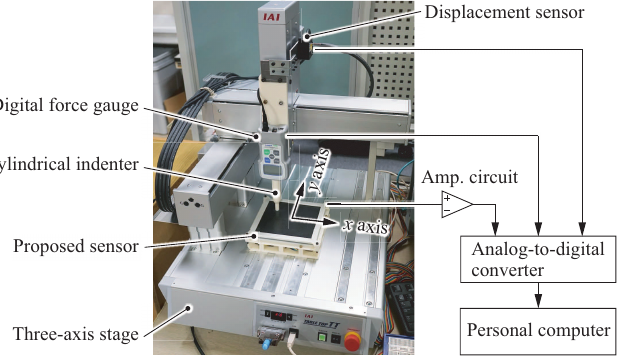
Figure 5. Experimental setup for investigating the sensor